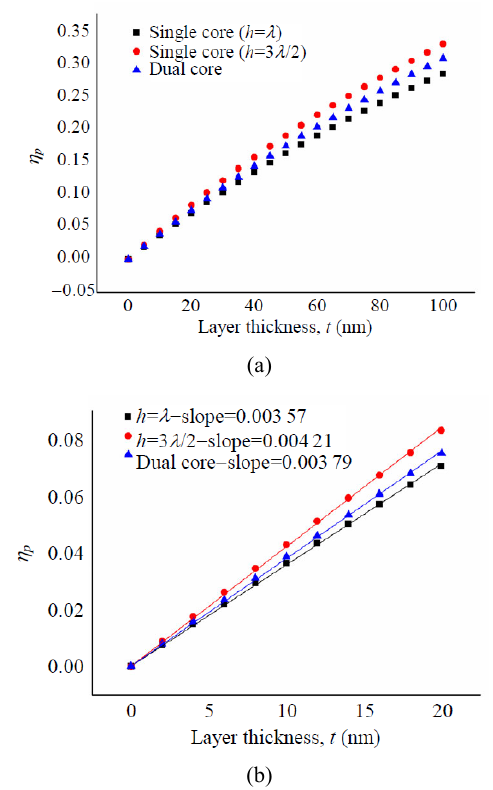
Fig. 7 Values of the parameter  thickness t for a range of (a) 100 nm and (b) 20 nm (zooming).